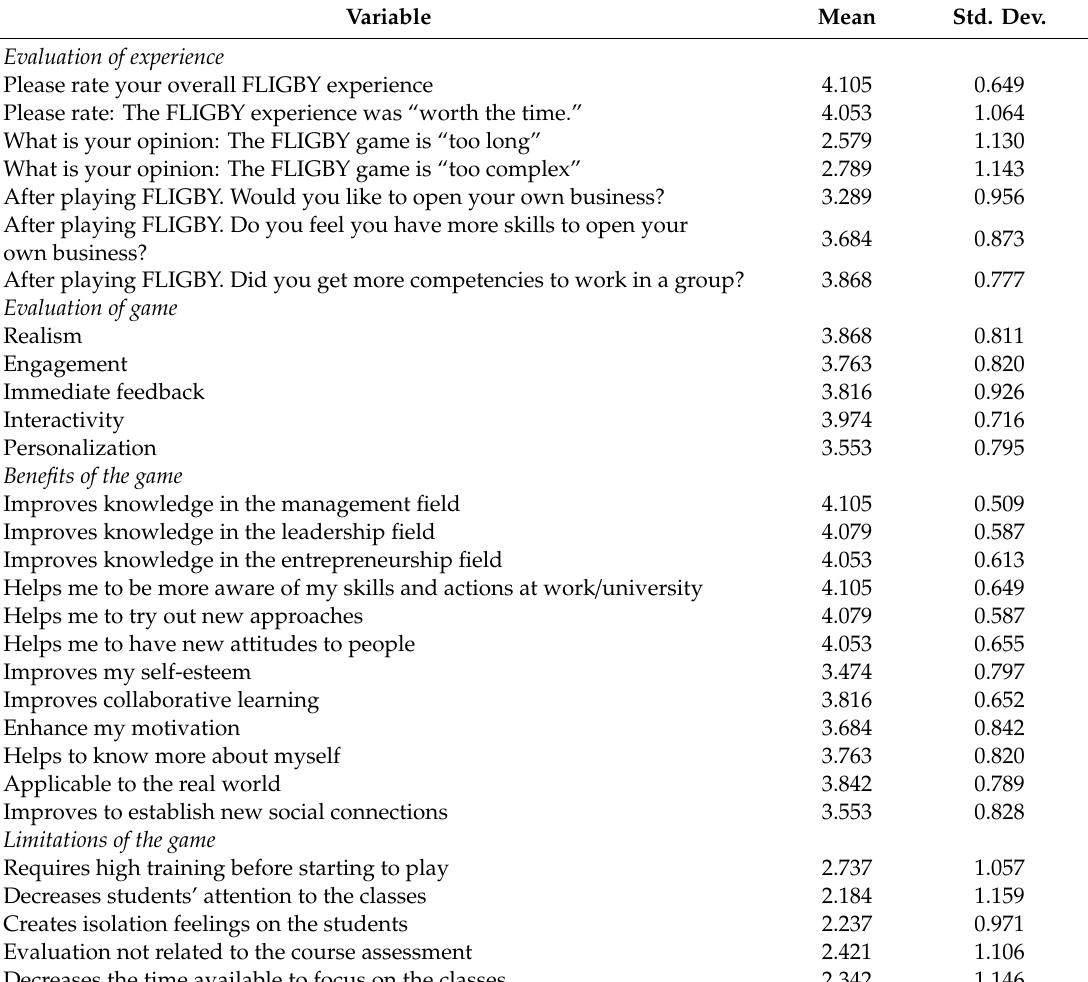
Table 2. Sample characteristics of the survey (phase